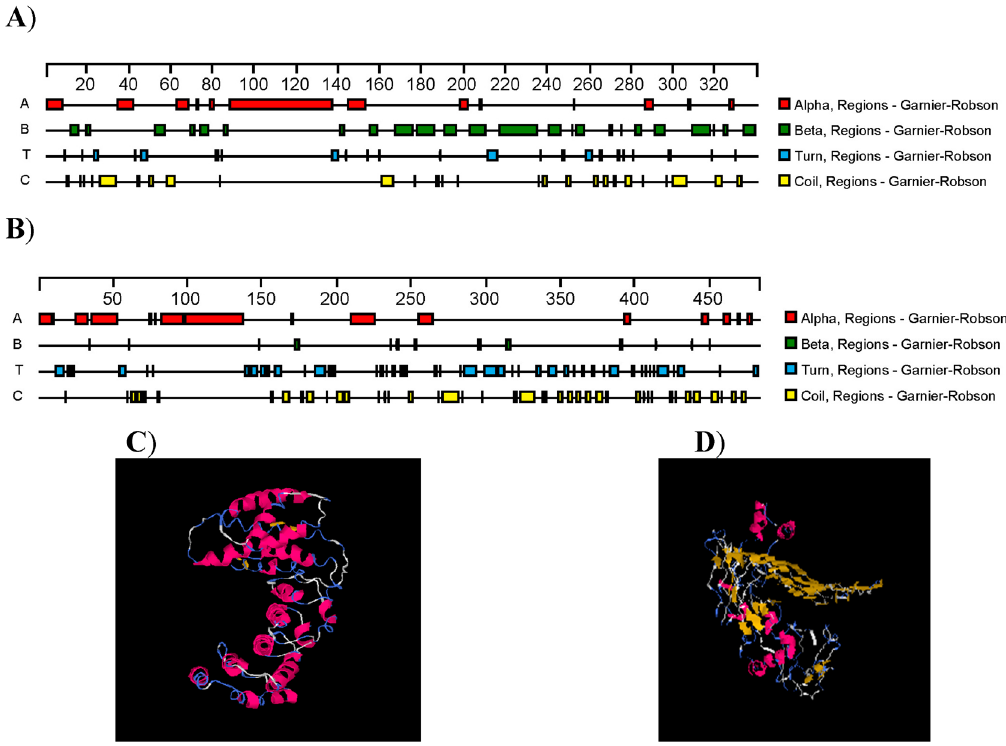
Figure 4. Tertiary structures of ( A ) LsSox2 and ( B ) LsSox9 ; secondary structures of ( C ) LsSox2 and ( D ) LsSox9.